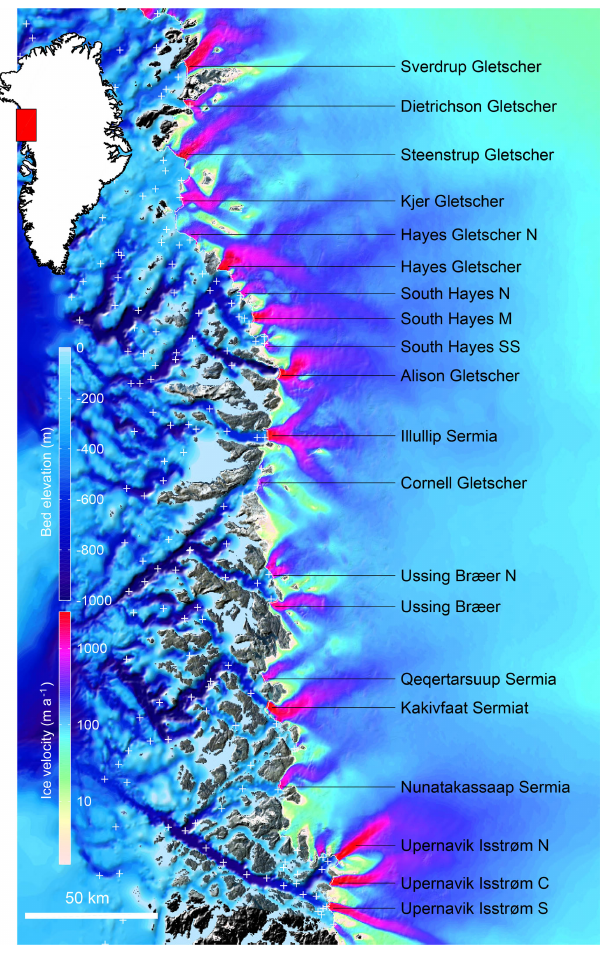
Figure 1. Ocean bathymetry (m, blue color scale) and ice velocity (ma − 1 , Joughin et al., 2010) of northwestern Greenland. The white line shows the 2007 ice sheet extent and white crosses indicate the locations of CTD data from NASA’s Oceans Melting Greenland campaign that are used to calibrate the thermal